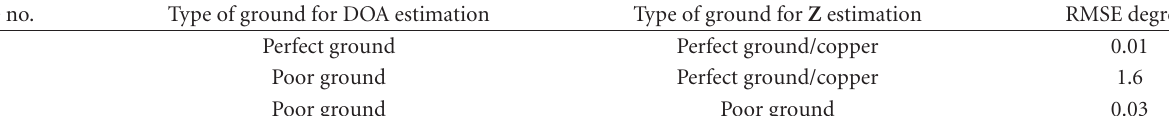
Table 3: RMSE of DOA Estimation for array for perfect and poor ground.